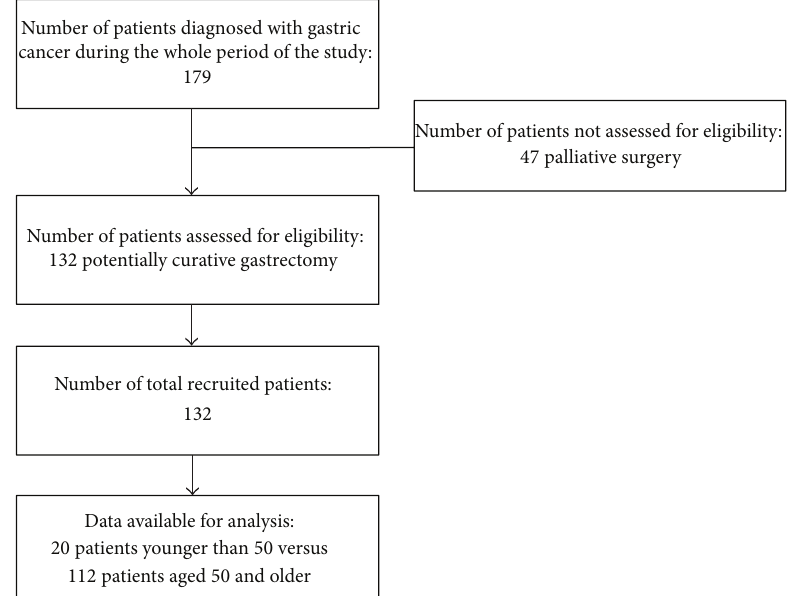
Figure 1: Flowchart of patients with gastric cancer included in the retrospective cohort